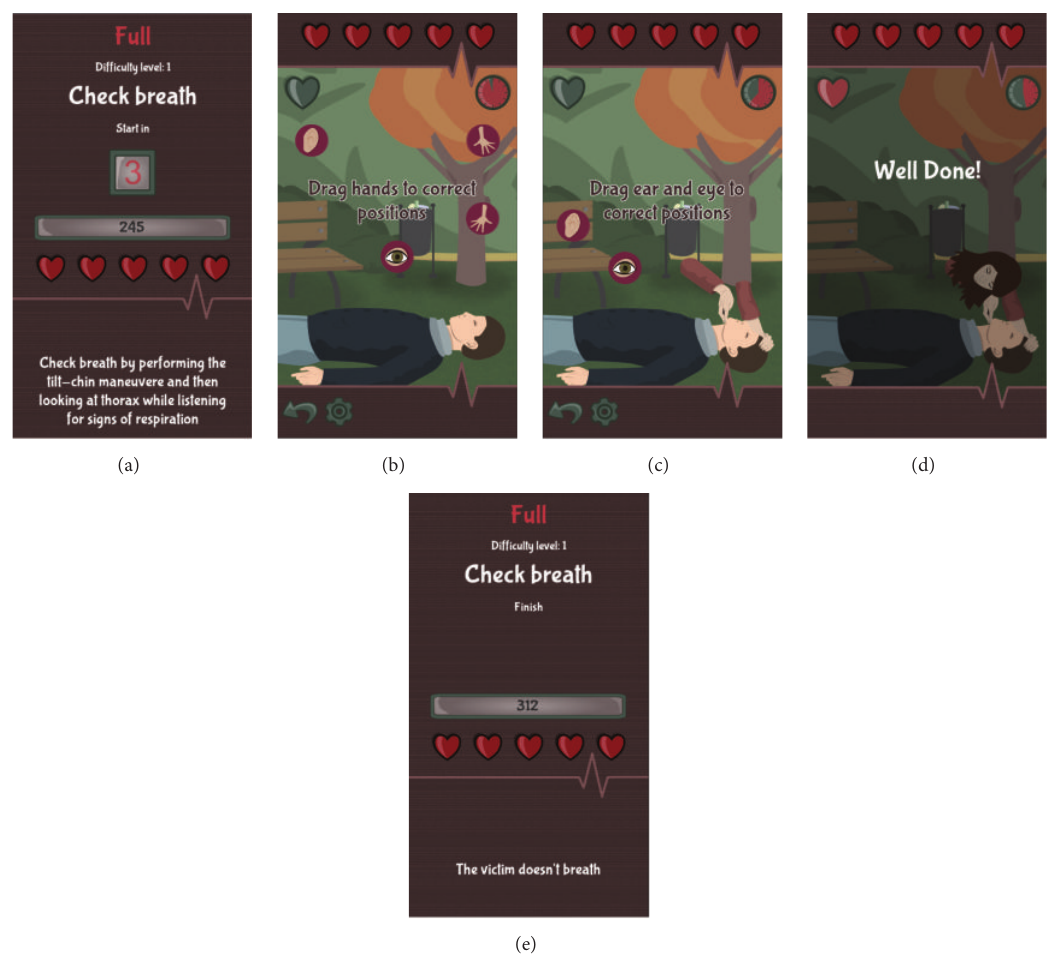
Figure 7: Screens of the Check Breath mini game. (a) Init screen with game instructions. (b) Scene with the icons that have to be placed in the correct positions. (c) Tilt-chin maneuver once hands have been correctly placed. (d) Look and listen for breath once eye and ear icons have been correctly placed. (e) Final screen with the score and the message that the victim is not